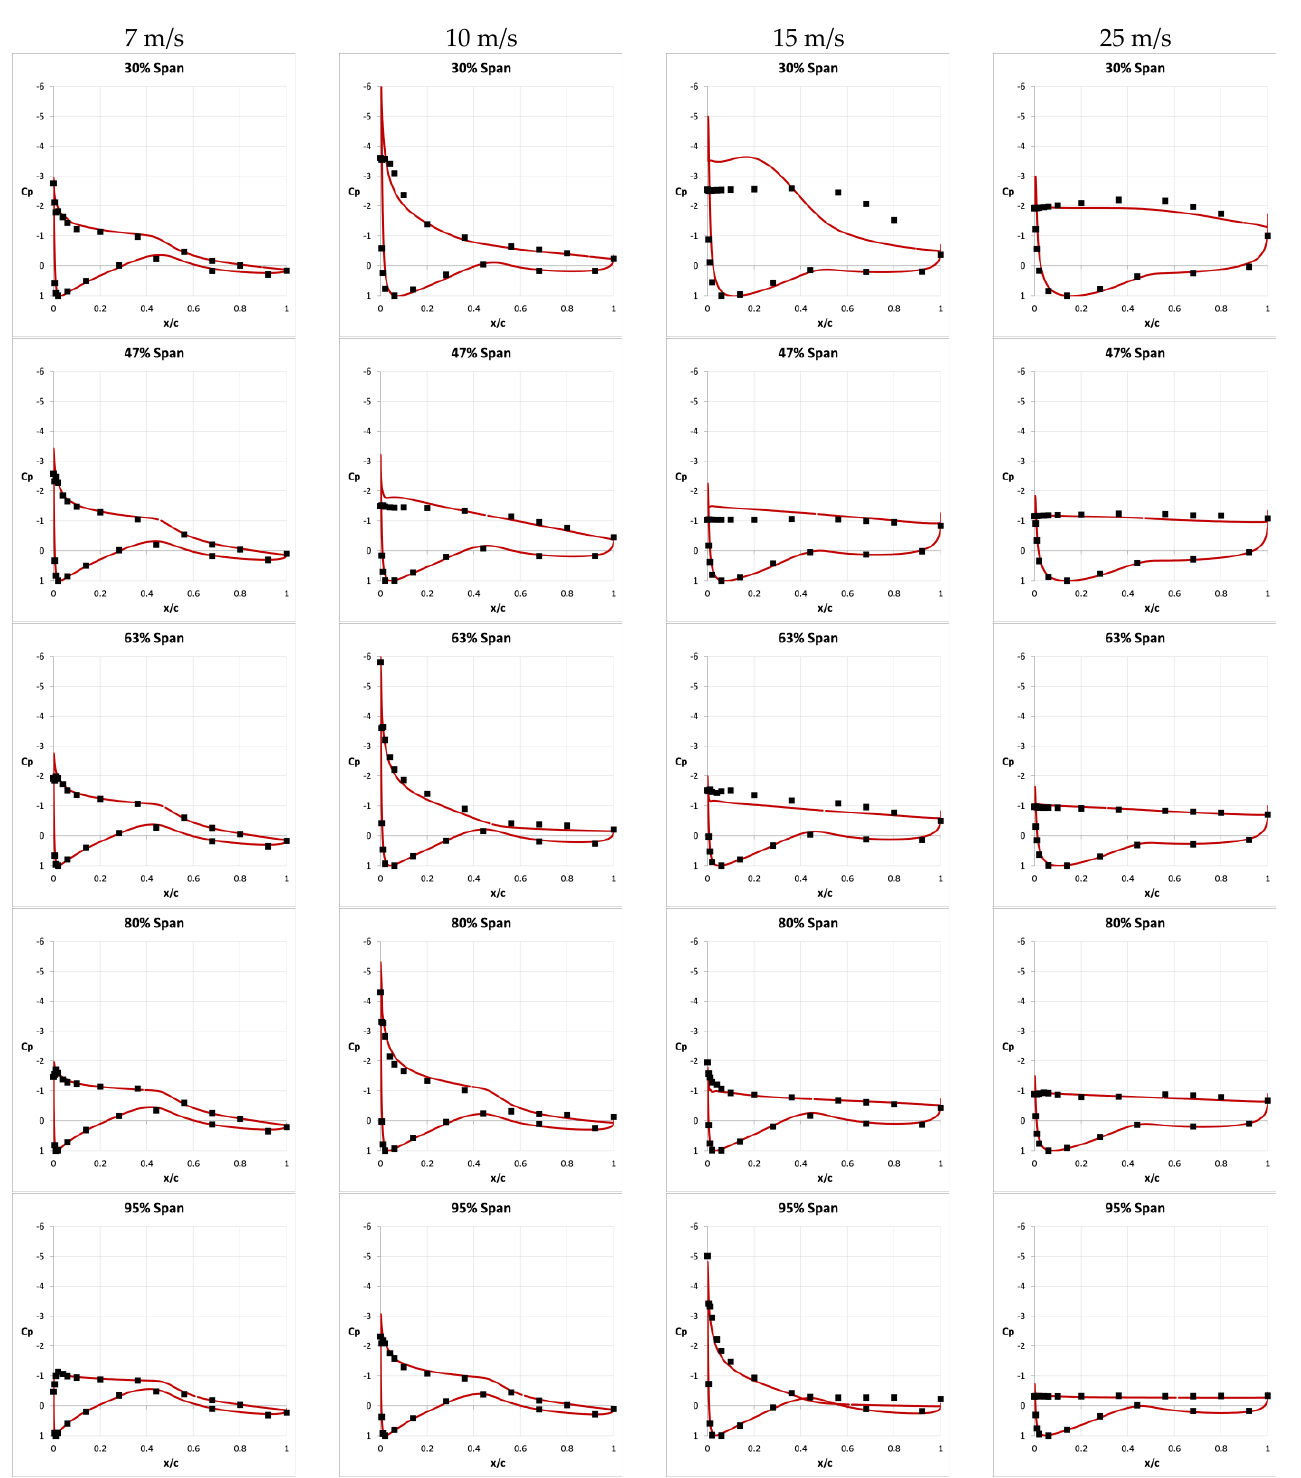
Figure 11. Pressure coefficient distribution vs. measured data at four representative wind velocities. Each column represents a wind speed; data extracted at five radial stations. Experimental data is represented as black squares and numerical data is drawn as red curves.